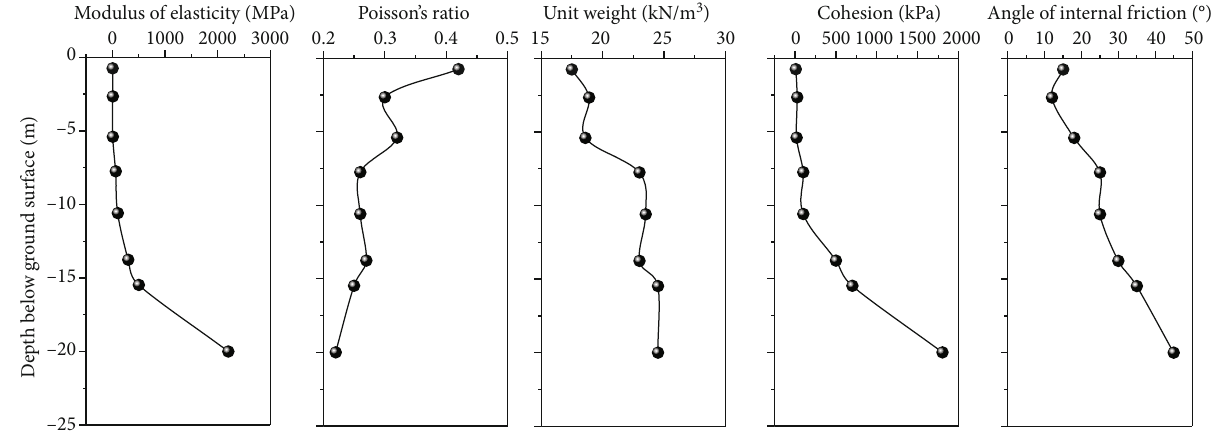
Figure 2: Pro fi le of Section B-B.